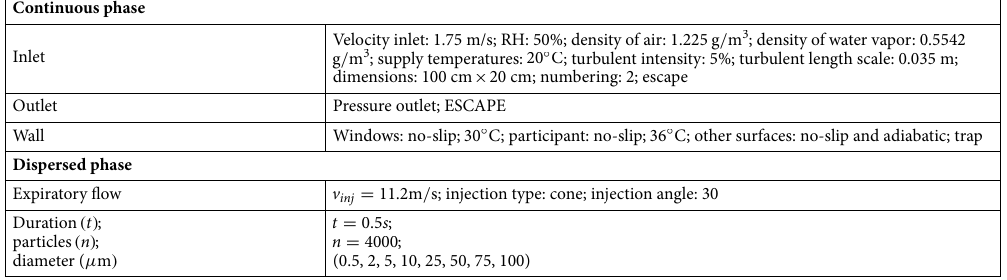
Table 1. Summary of continuous and dispersed phases boundary